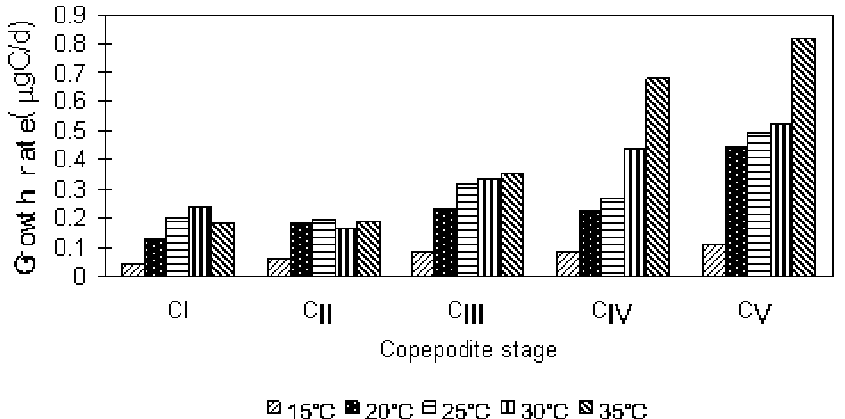
FIGURE 4. Effect of temperature on growth rate of P. dubia